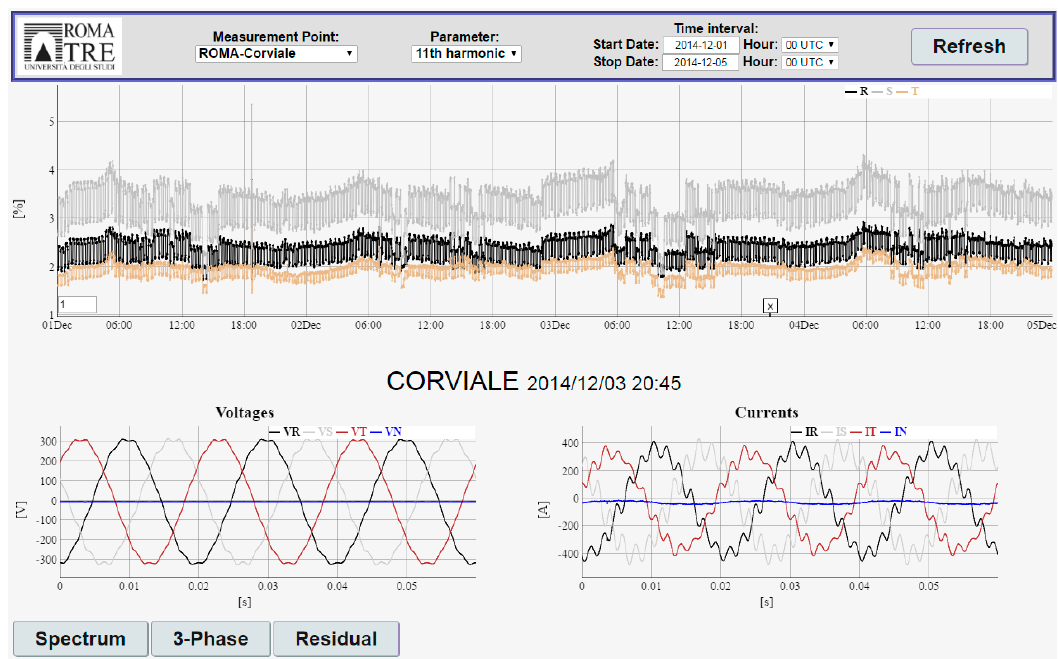
Figure 13. The figure shows the main page of the web site. The control bar on the top allows for the selection and visualization of the measurement point, the parameter, and the period on the graph. In the screenshot, the time evolution of the 11th harmonic from 1 to 5 of December 2014 is displayed. By right-clicking on a point of the graph, it is possible to show the waveforms of the voltages and of the currents recorded in the period related to the specific point. A series of buttons allow accessing additional analysis windows. additional analysis